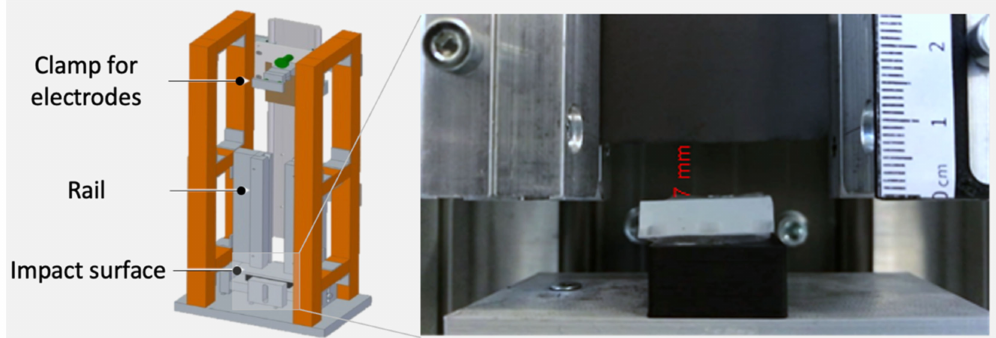
Figure 9. CAD Model of edge collision test rig ( left ) and a close-up of a bouncing electrode ( right ).